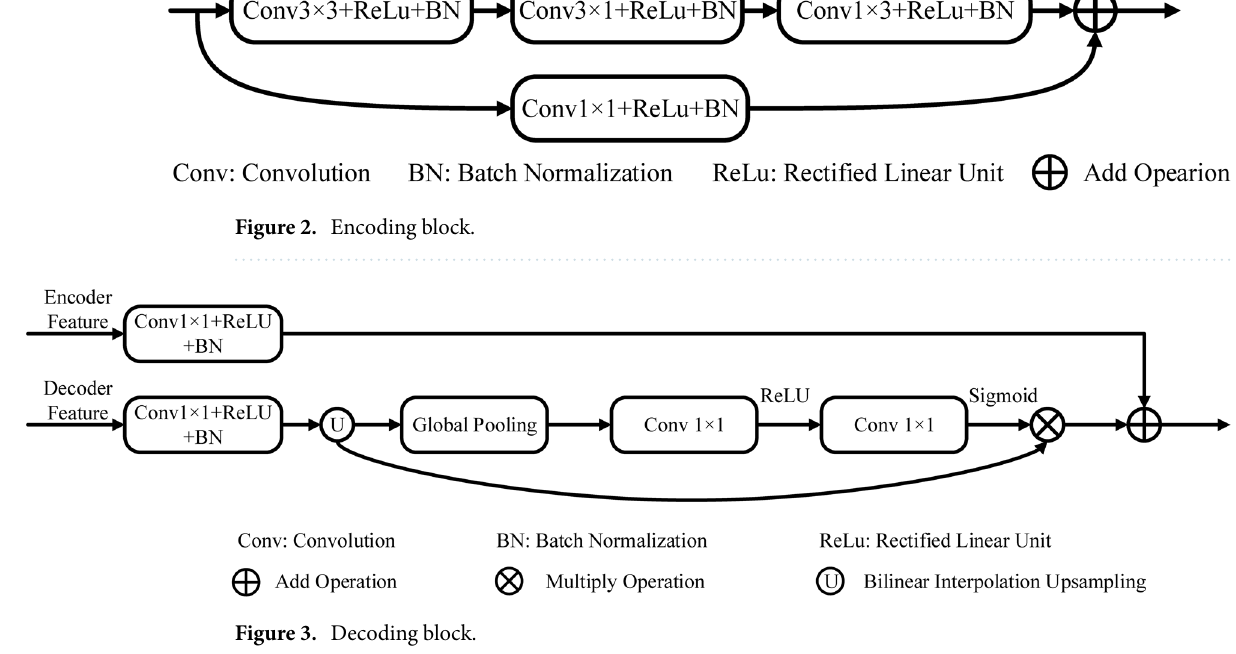
Figure 3. Decoding